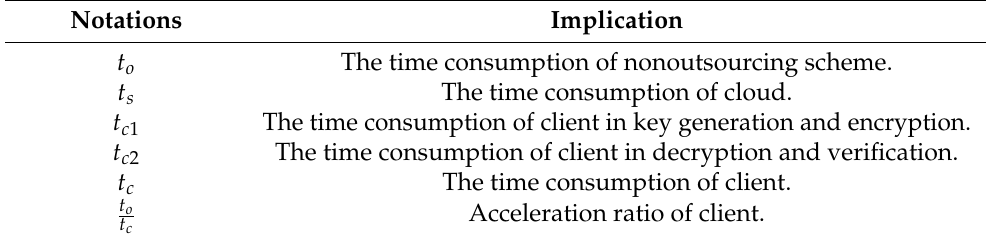
Table 7. Notations in